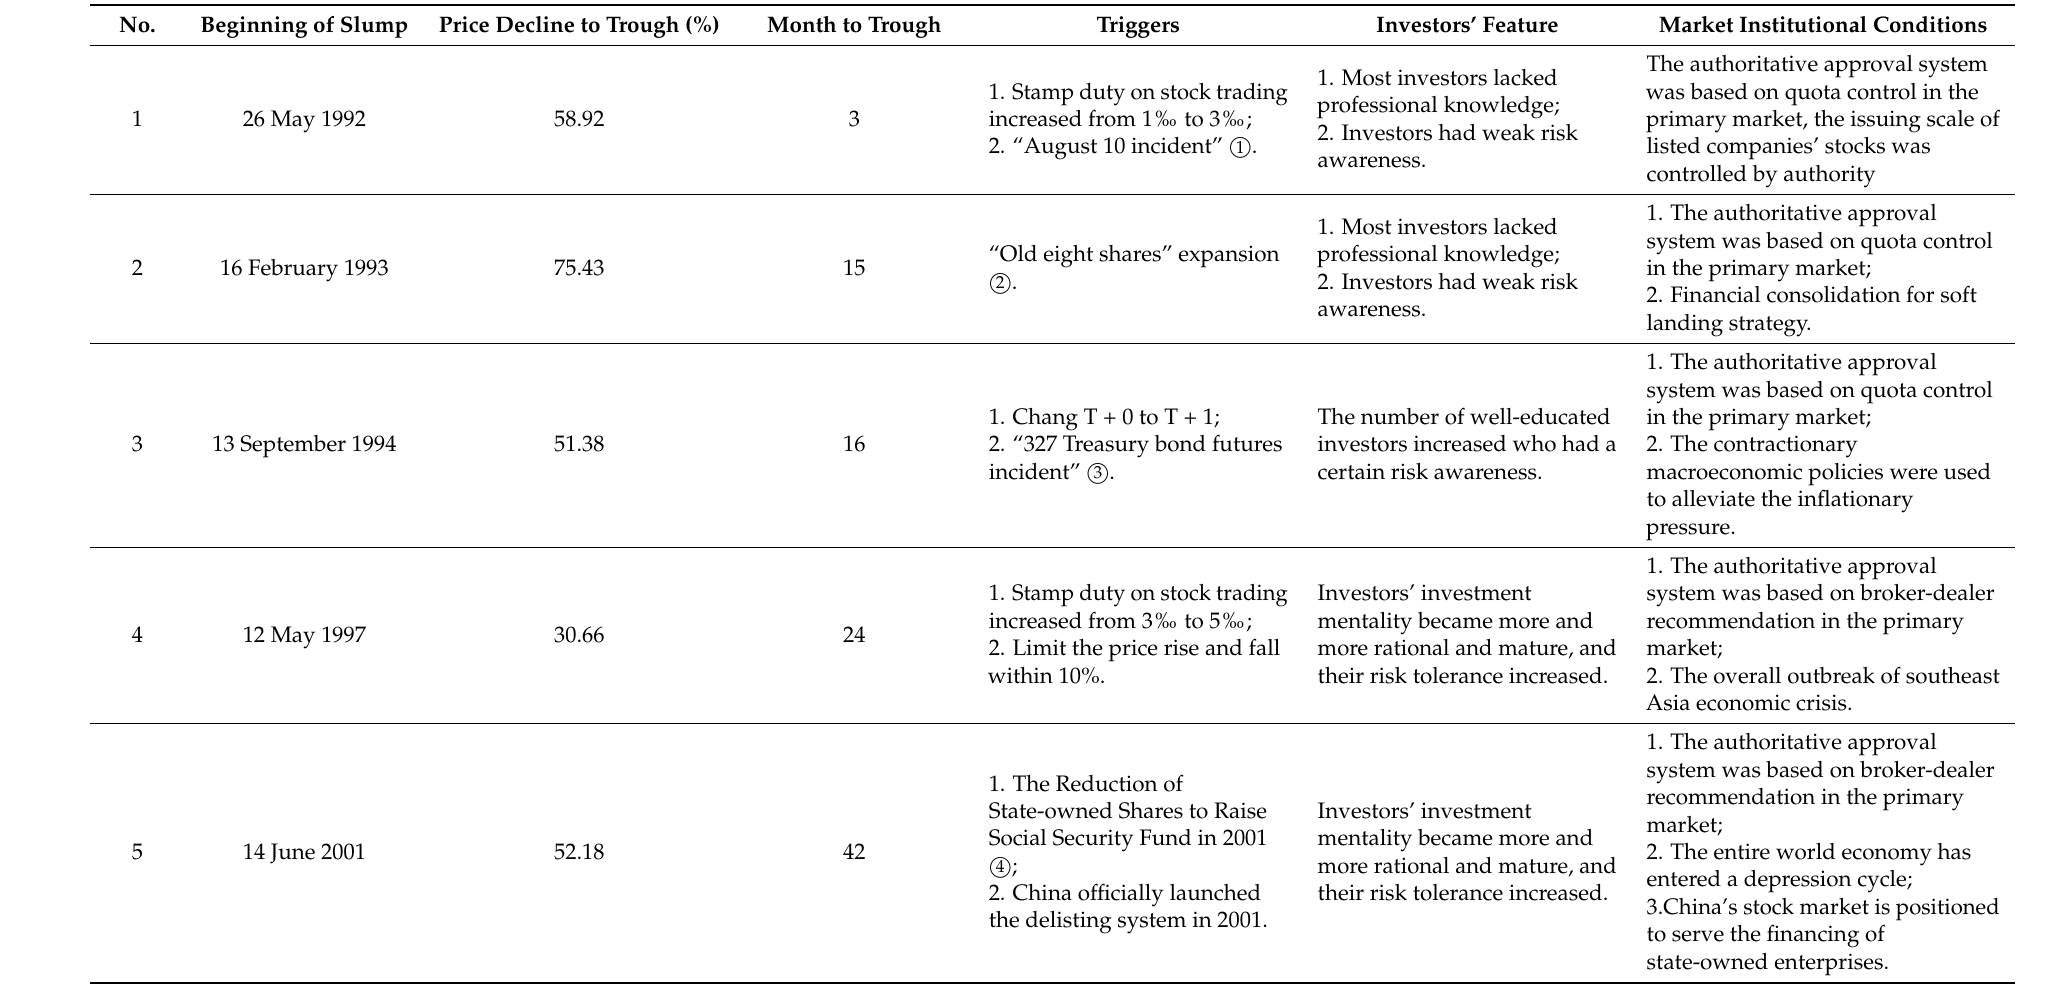
Table 1. Chinese stock market slump samples and their